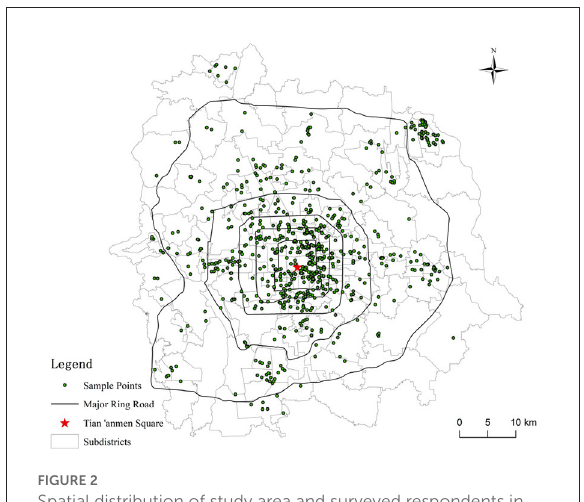
FIGURE2 Spatial distribution of study area and surveyed respondents in